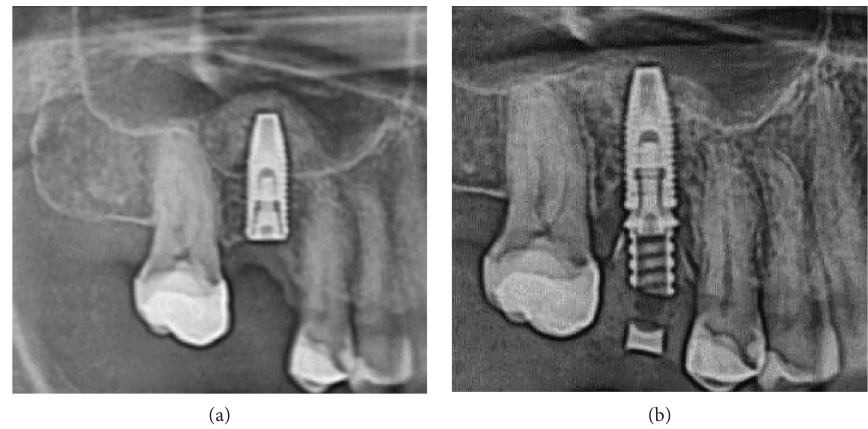
Figure 1: Dynamics of bone resorption: (a) complete implant integration after 6 months; (b) provisional crown on the implant 3 weeks after